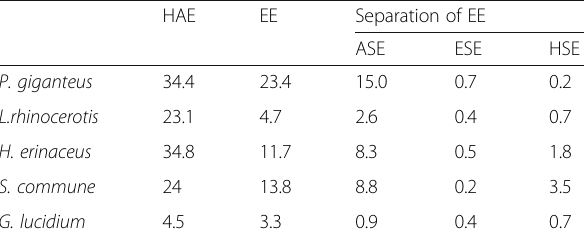
Table 2 The percentage of extraction yield of the mushroom extracts HAE EE Separation of EE ASE ESE